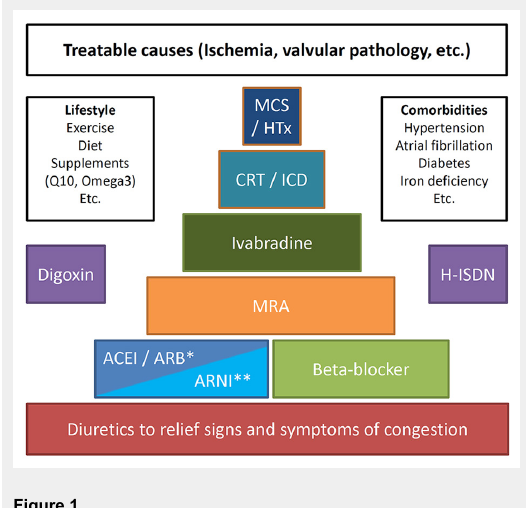
Overview on current therapies for heart failure with reduced ejection fraction (HFrEF). The pyramid depicts the